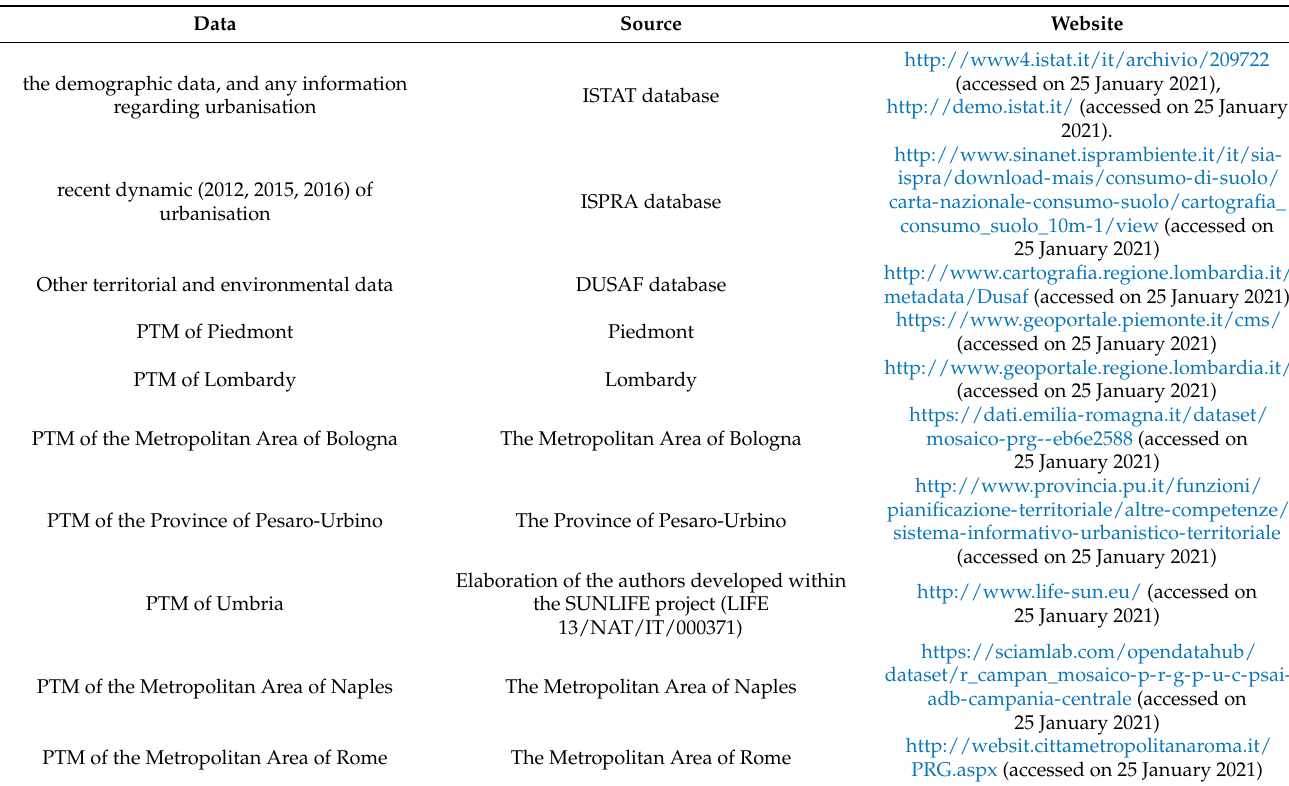
Table 1. Databases used for the